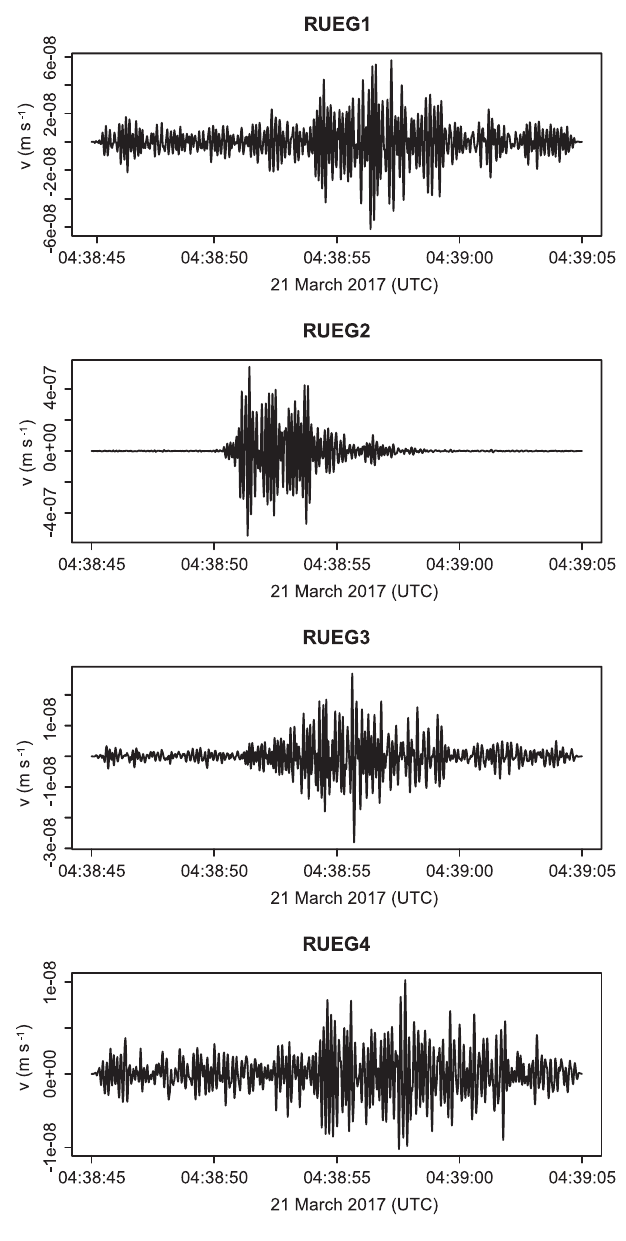
Figure 5. Seismic waveforms of a cliff coast collapse as recorded by four stations in the Jasmund National Park. Signals have been deconvolved, detrended, filtered between 5 and 8Hz, and tapered by 300 samples. Note that time offset and amplitude decrease as the event is recorded further away from its origin about 80m east of station